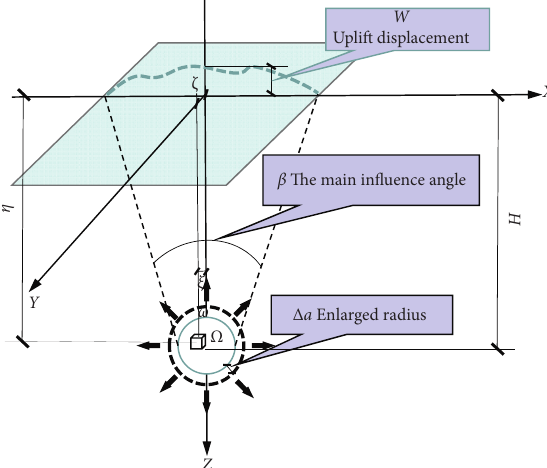
Figure 1: Schematic diagram of the elements of the foam slurry analyzed based on